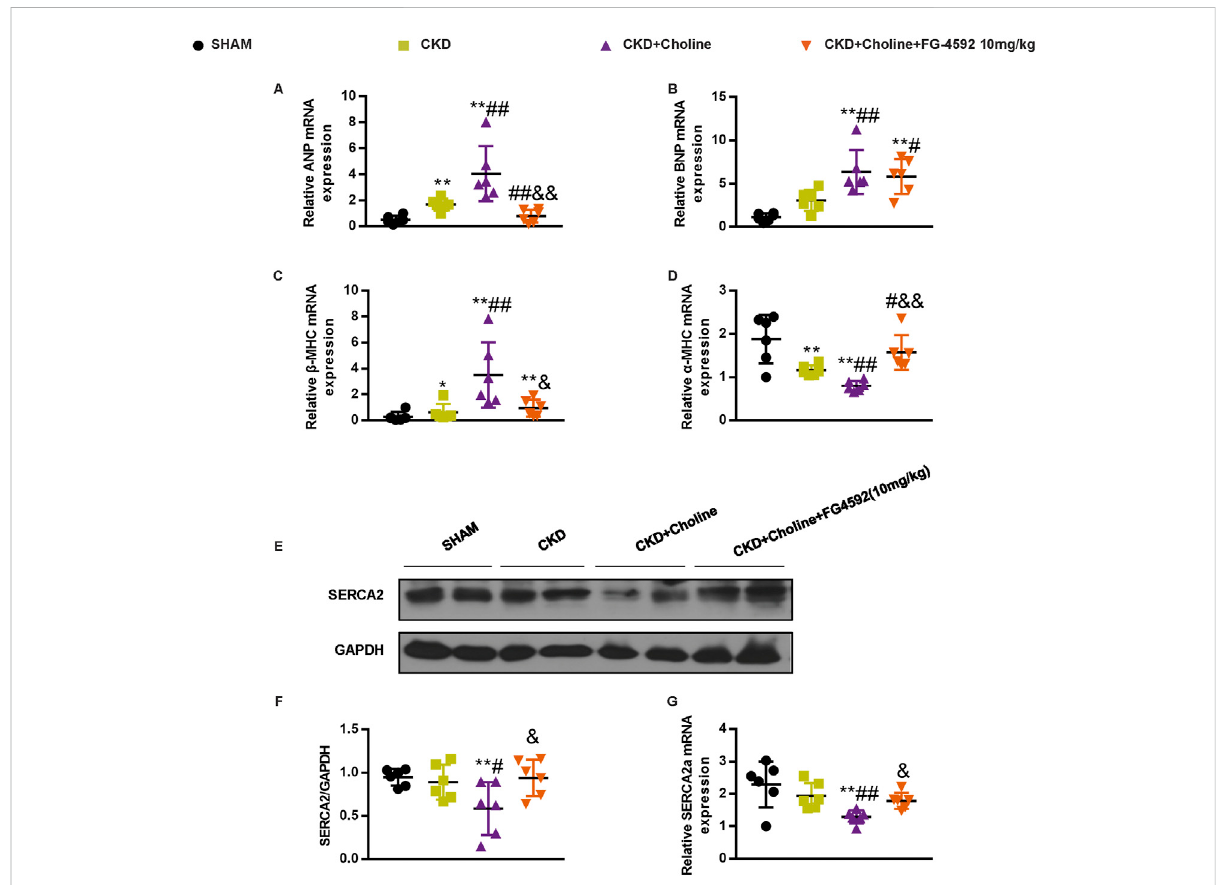
FIGURE 9 FG-4592 inhibits the changes of cardiac hypertrophy markers and SERCA2 expression in 5/6 Nx mice on a high-choline diet. (A – D) The mRNA levels of ANP, BNP, β -MHC, and α -MHC were measured by real-time PCR. (E) The protein levels of SERCA2 were measured by western blotting. (F) Graphic representation of relative abundance of SERCA2 normalized to GAPDH. (G) The mRNA levels of SERCA2 were measured by real-time PCR. The data are presented as themean ± SD.* p < 0.05 and ** p < 0.01 vs. SHAM group; # p < 0.05 and ## p < 0.01 vs. CKD group; & p < 0.05 and && p < 0.01 vs. CKD + Choline group. n = 6 in each